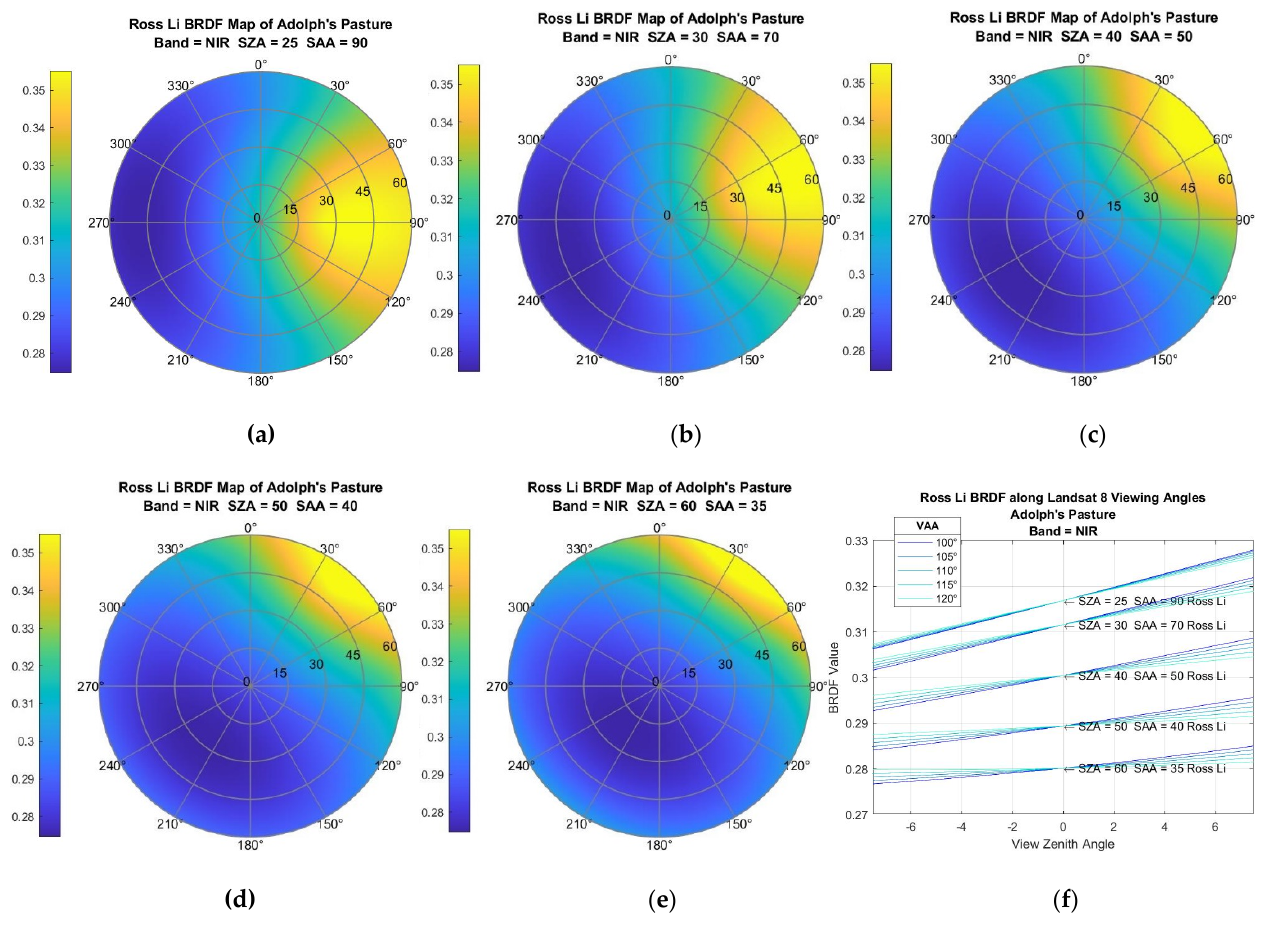
Figure 4. ( a – e ): BRDF models of grass pasture for different SZA and SAA locations. Note how hot spot follows solar location. ( f ): Linearity of BRDF versus VZA for entire range of Landsat viewing angles.